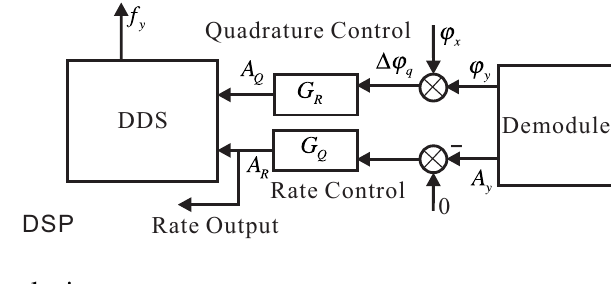
Figure 14. The structure frame of the y -axis control loop.